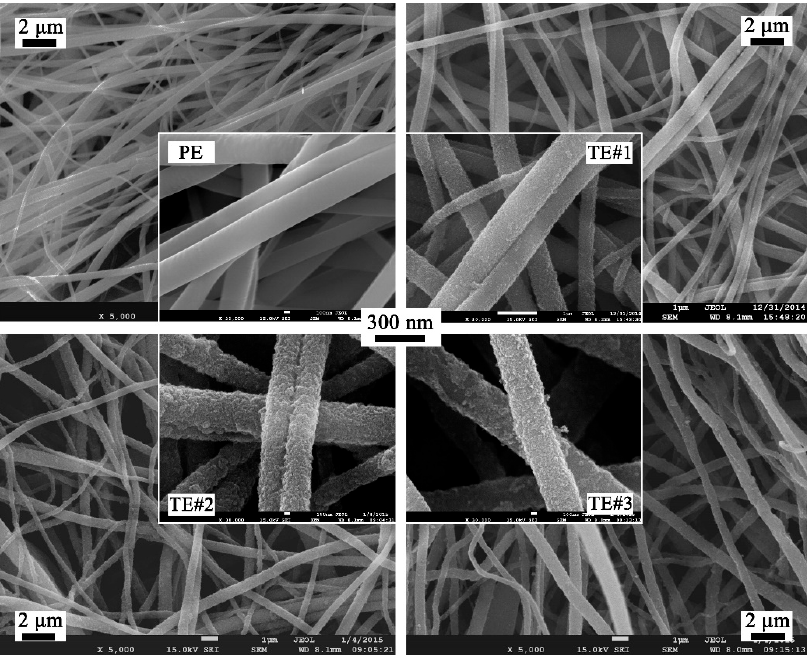
Figure 2. SEM images of PE and TE#1 ‒ TE#3 at magnifications of 5000 and 30,000.